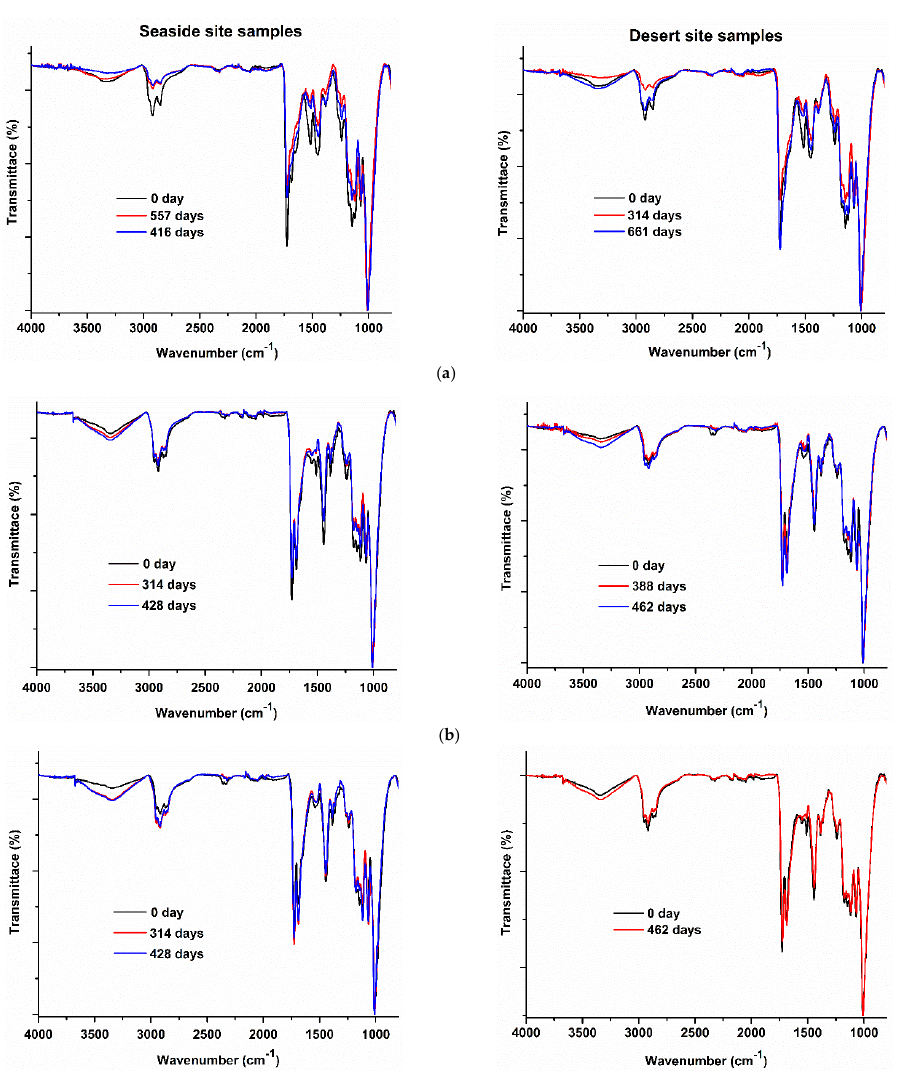
Figure 2. FTIR-ATR paint spectra of ( a ) mirror A1, ( b ) mirror C2, and ( c ) mirror D2, exposed on both outdoor testing sites (Seaside and desert sites).